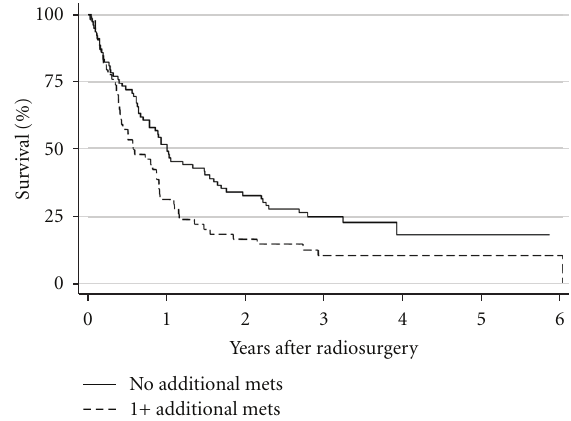
Figure 3: Kaplan-Meier plot of overall survival after GK-SRS for all 133 patients, stratified by the number of additional metastases identified at the time of GK-SRS.